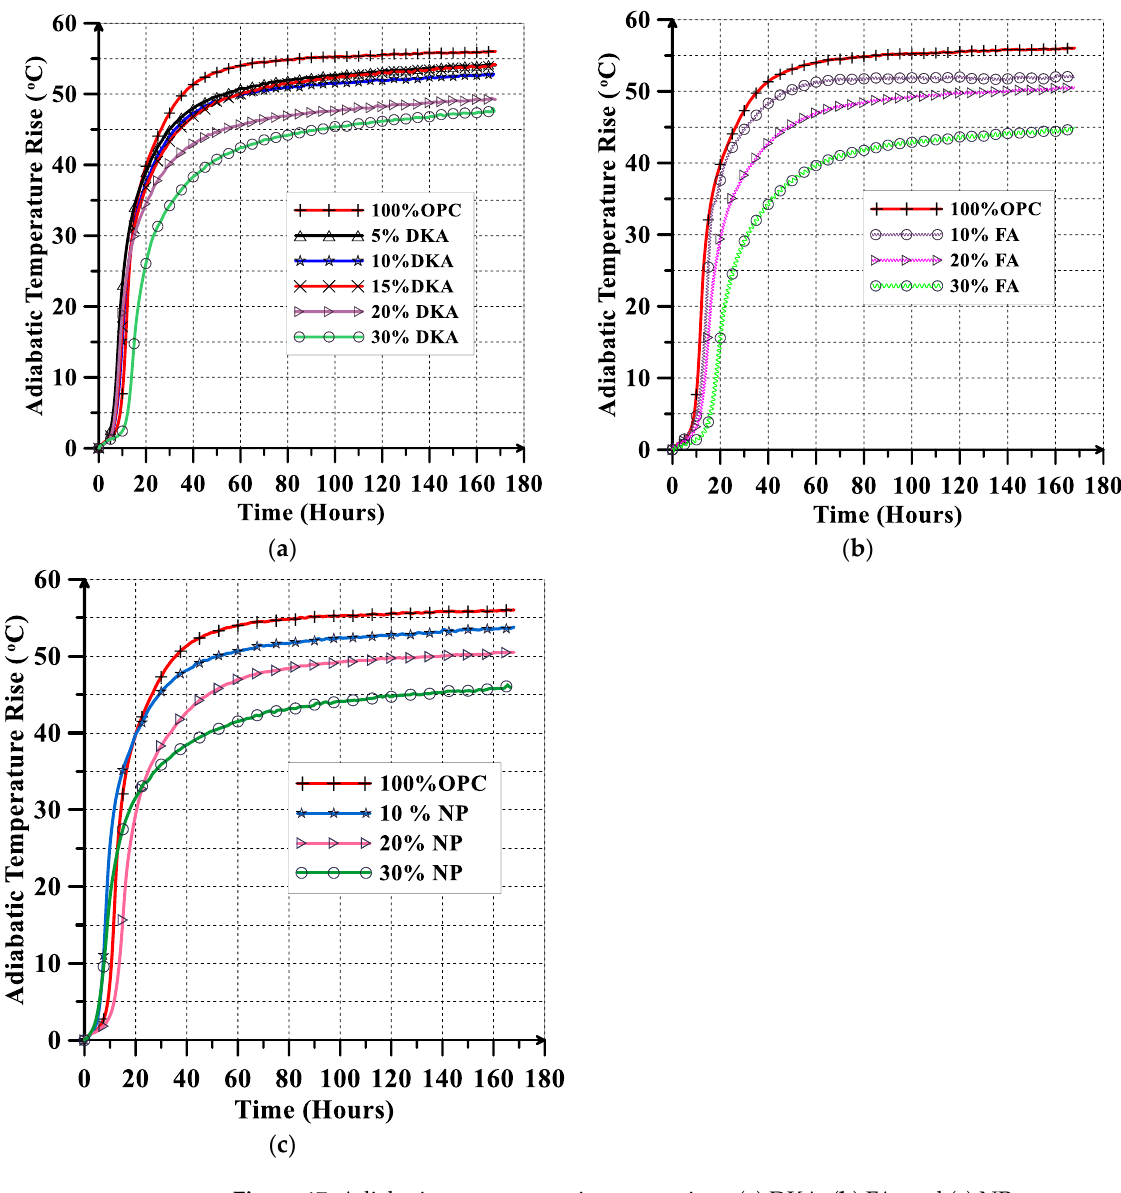
Figure 17. Adiabatic temperature rise versus time: ( a ) DKA, ( b ) FA, and ( c ) NP. The maximum rate of change in the heat of hydration and the rate of the temperature rise measured for the twelve concrete mixes are shown in Figure 18a – c. The mix with a 10% DKA replacement has the highest hydration rate, 13.2 KJ/kg.hr, while the mix with a 30% DKA replacement has the lowest hydration rate, 9.1 KJ/kg.hr, as shown in Figure 18a. The temperature rise rates for the control mixture and the mixtures with 5% and 10% DKA were 2.4 dC/h. The mixture containing 30% FA had the lowest temperature rise rate, 1.6 dC/h. The rate of the temperature rise gradually decreases, as seen in Figure 18a – c, when the percentage of replacement with DKA, NP, and FA increases from 10% to 30%.